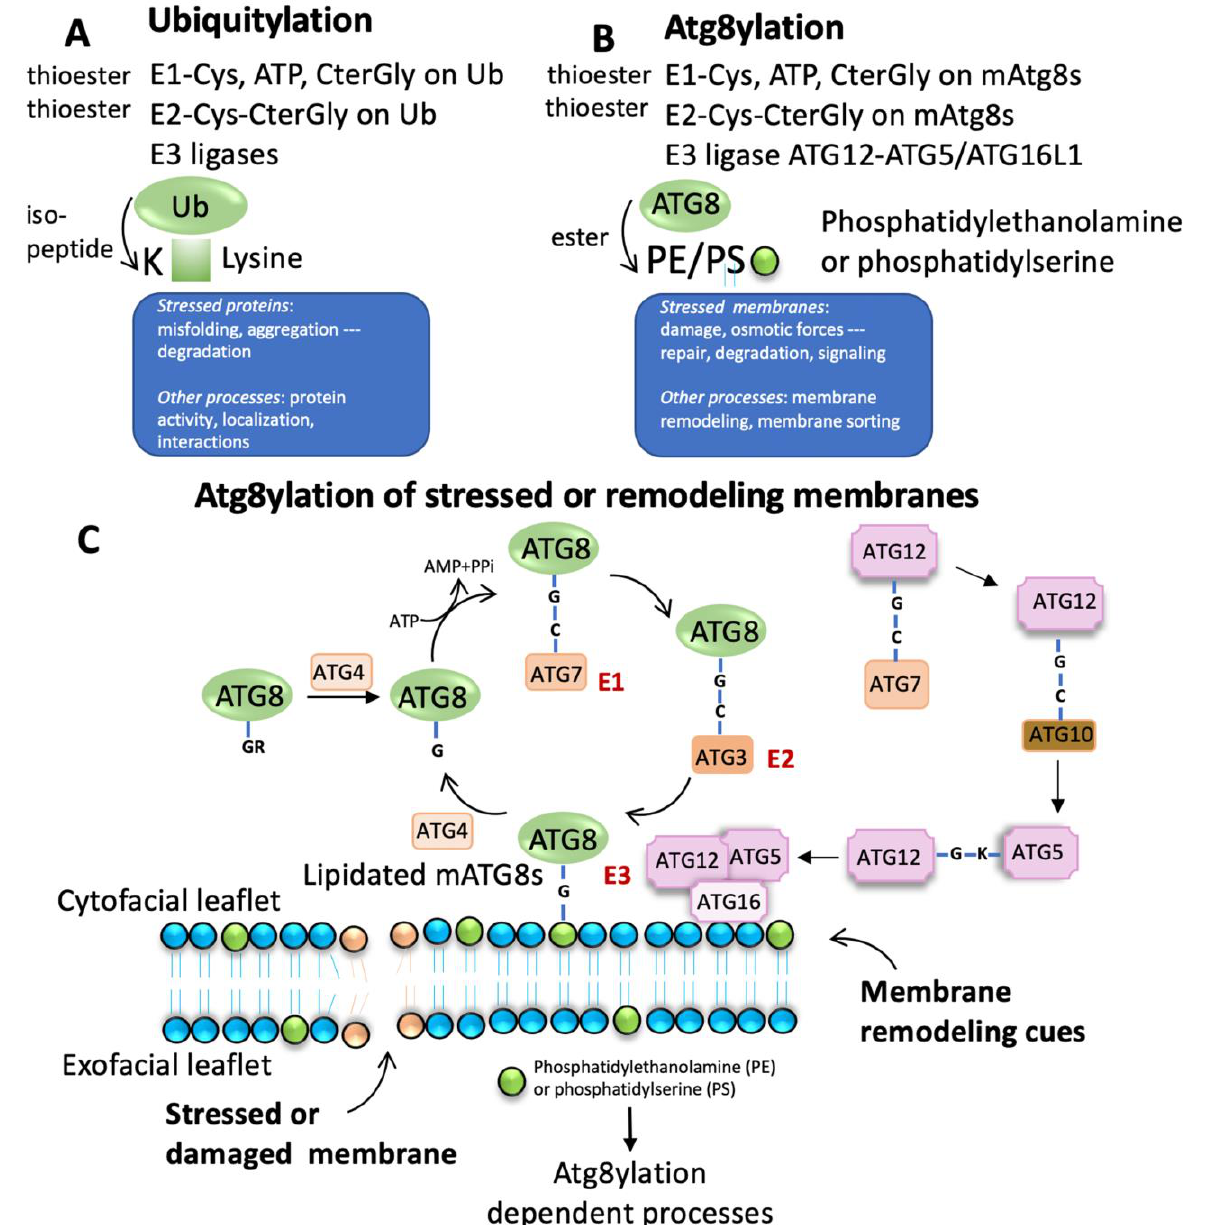
FIGURE 1: Comparison between ubiquitylation and Atg8ylation. (A) Principal components and steps of ubiquitylation. Note that misfolded or aggregated or otherwise engaged proteins are the principal targets for ubiquitylation. (B) Principal components and steps of Atg8ylation. Note that stressed membranes or membranes destined for a specific kind of remodeling are the principal targets for Atg8ylation. (C) The well-established lipidation cycle of mAtg8s (mammalian Atg8s: LC3A,B,C, GABARAP, GABRAPL1 and GABARAPL2) on target membranes. Green circles, polar groups of PE or